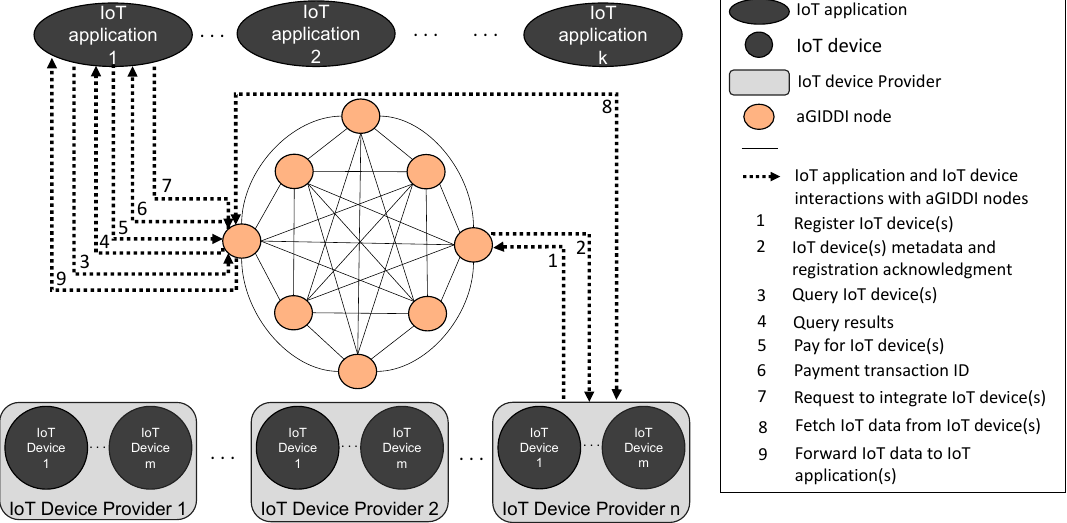
Figure 1. High-level architecture of aGIDDI.